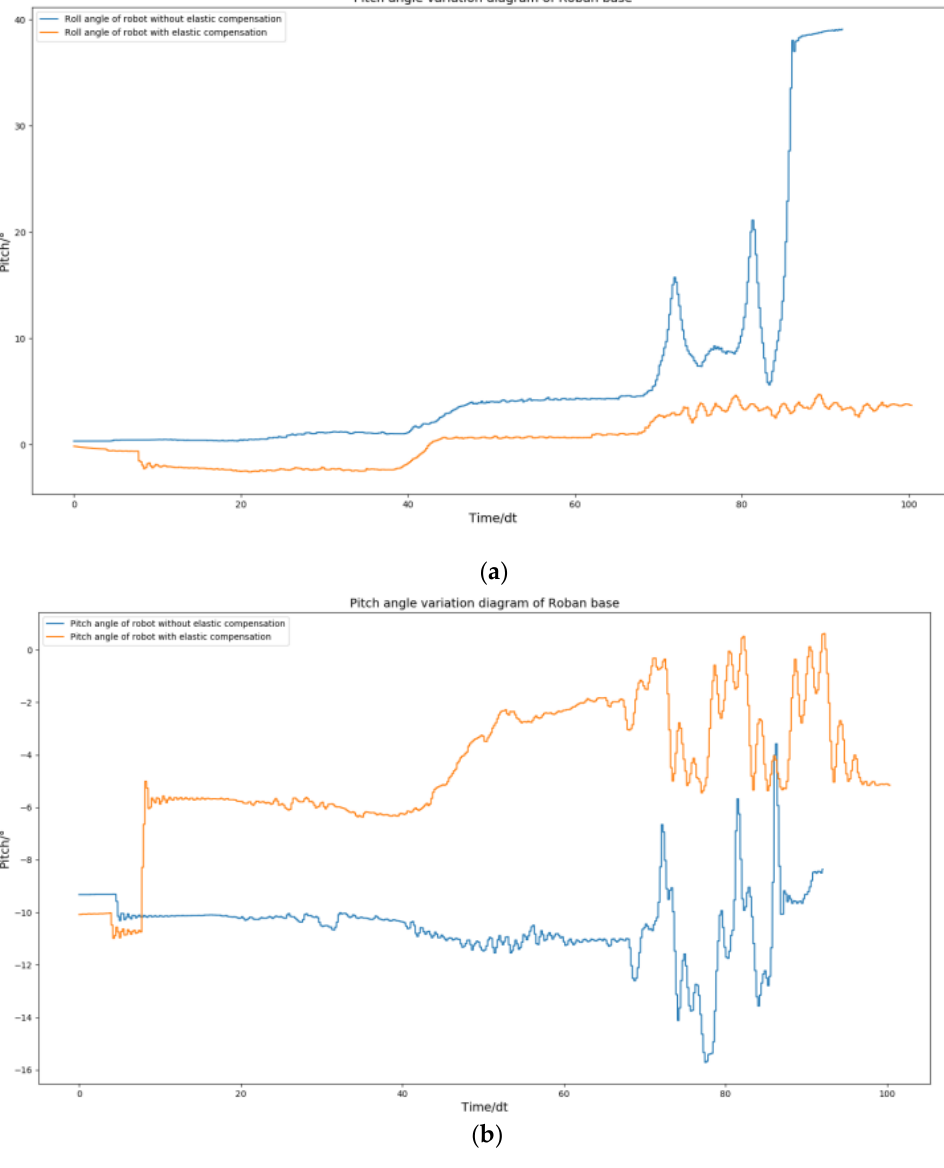
Figure 18. When Roban’s COM moves 4.3 cm, and completes three squats on a single leg. The comparison chart shows the difference in roll angle and pitch angle between the robot with and without spring compensation. ( a ) Comparison diagram of roll angle change of robot with and without spring compensation. ( b ) Comparison diagram of roll pitch change of robot with and without spring compensation.